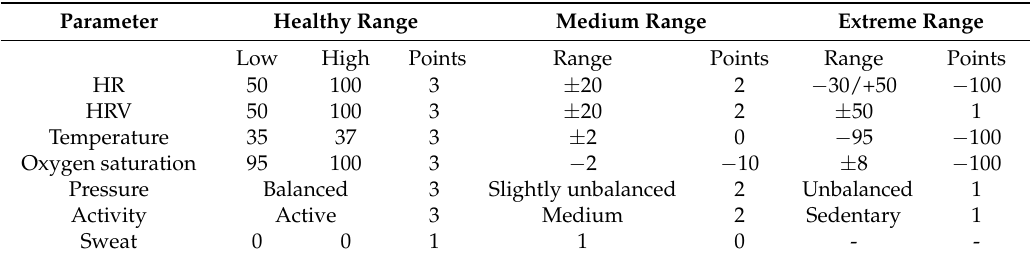
Table 1. Wellness assessment score distribution of points.